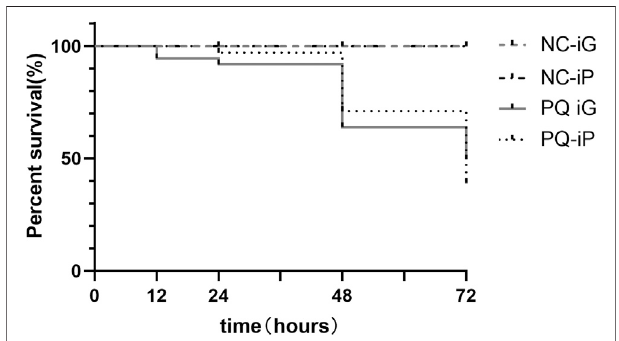
FIGURE 1 | Survival curves of rats in all groups after PQ